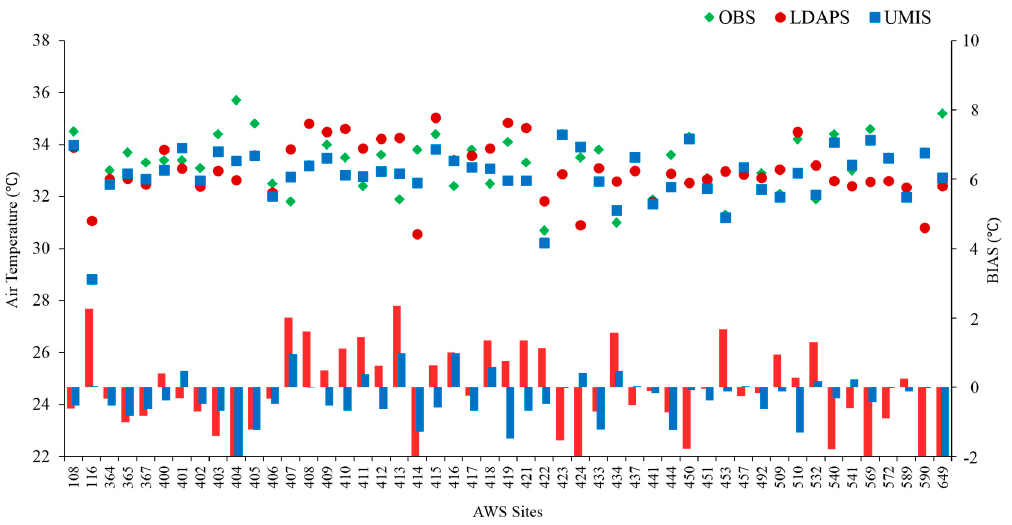
Figure 8. Evaluation of the temperature at the time of daily maximum temperature per automated weather station (AWS; forecast day: 04 August 2017 06:00 UTC). OBS, observed data; LDAPS, Local Data Assimilation and Prediction System; UMIS, Urban Meteorological Information System.